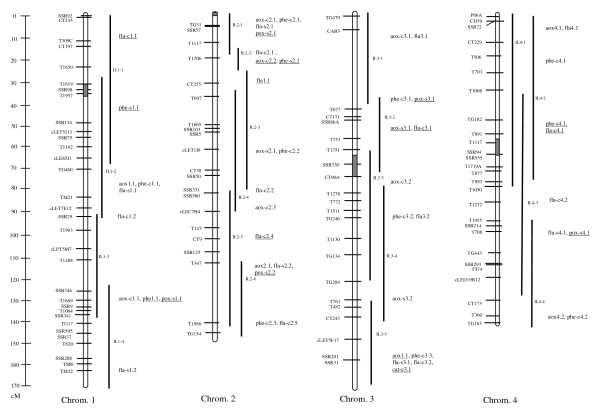
Linkage map for chromosomes 1 to 4 of the IL population showing the locations of QTL identified in this work. For loci that are underlined, S. pennellii alleles were associated with increased content/activity. Wild alleles for non-underlined loci were associated with decreased content/activity. Dotted underline indicates that the wild alleles were associated with both increased and decreased content/activity, depending on the environment (control or salt).